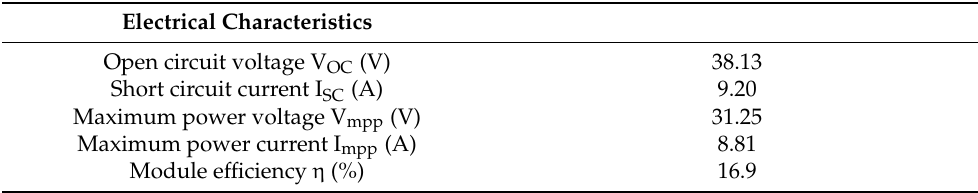
Table 1. Technical specification of the PV panel [31].